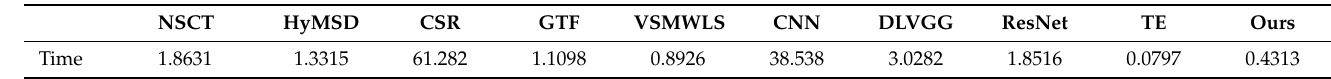
Table 3. Average running time of various methods on the Nato-Camp sequence images of 360 × 270 (Unit: